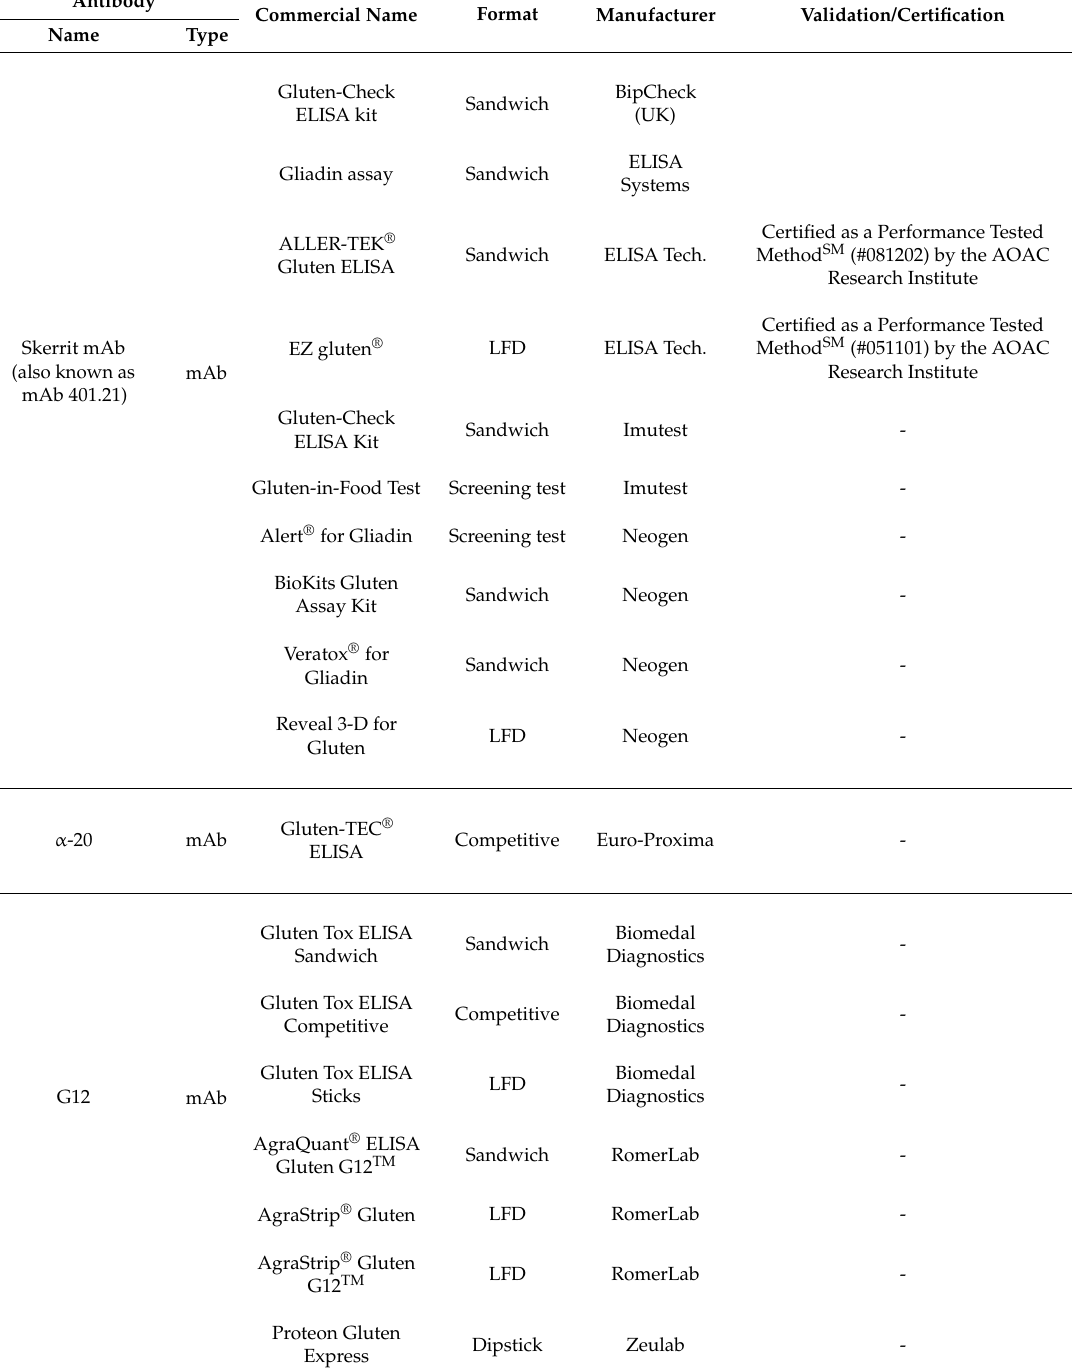
Table 1. List of commercial ELISA kits for gluten detection in